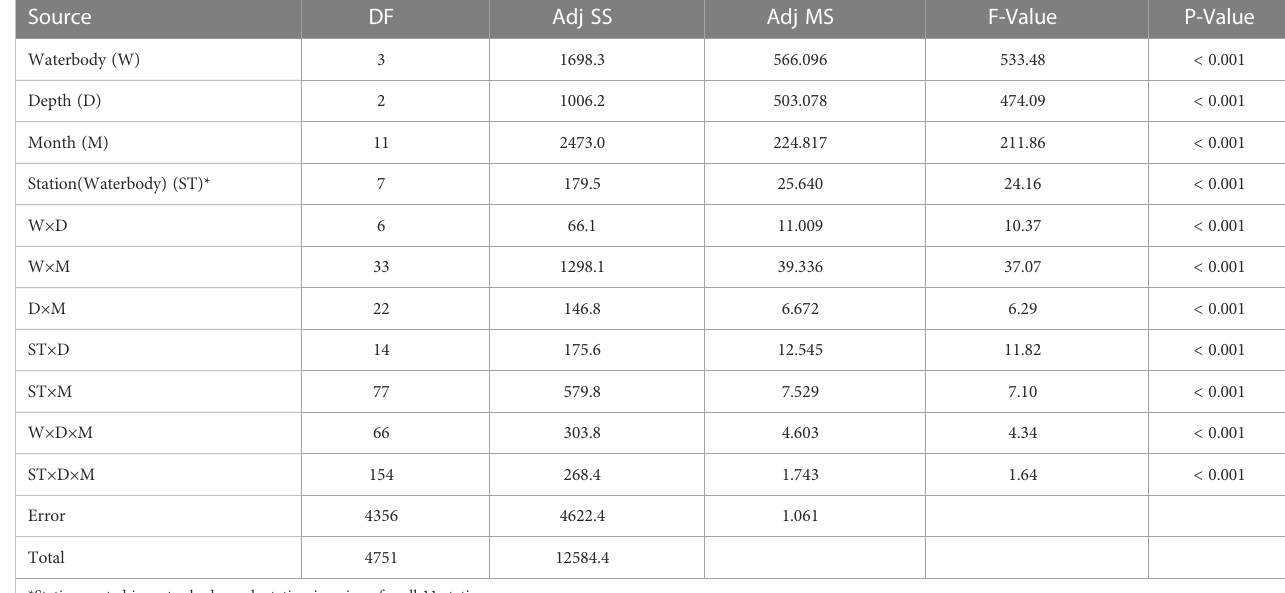
TABLE 1 Results of multi-way ANOVA of the spatial (water body, stations, and depth) and temporal (monthly) variations in C. tulipa spatfall in the selected coastal water bodies.